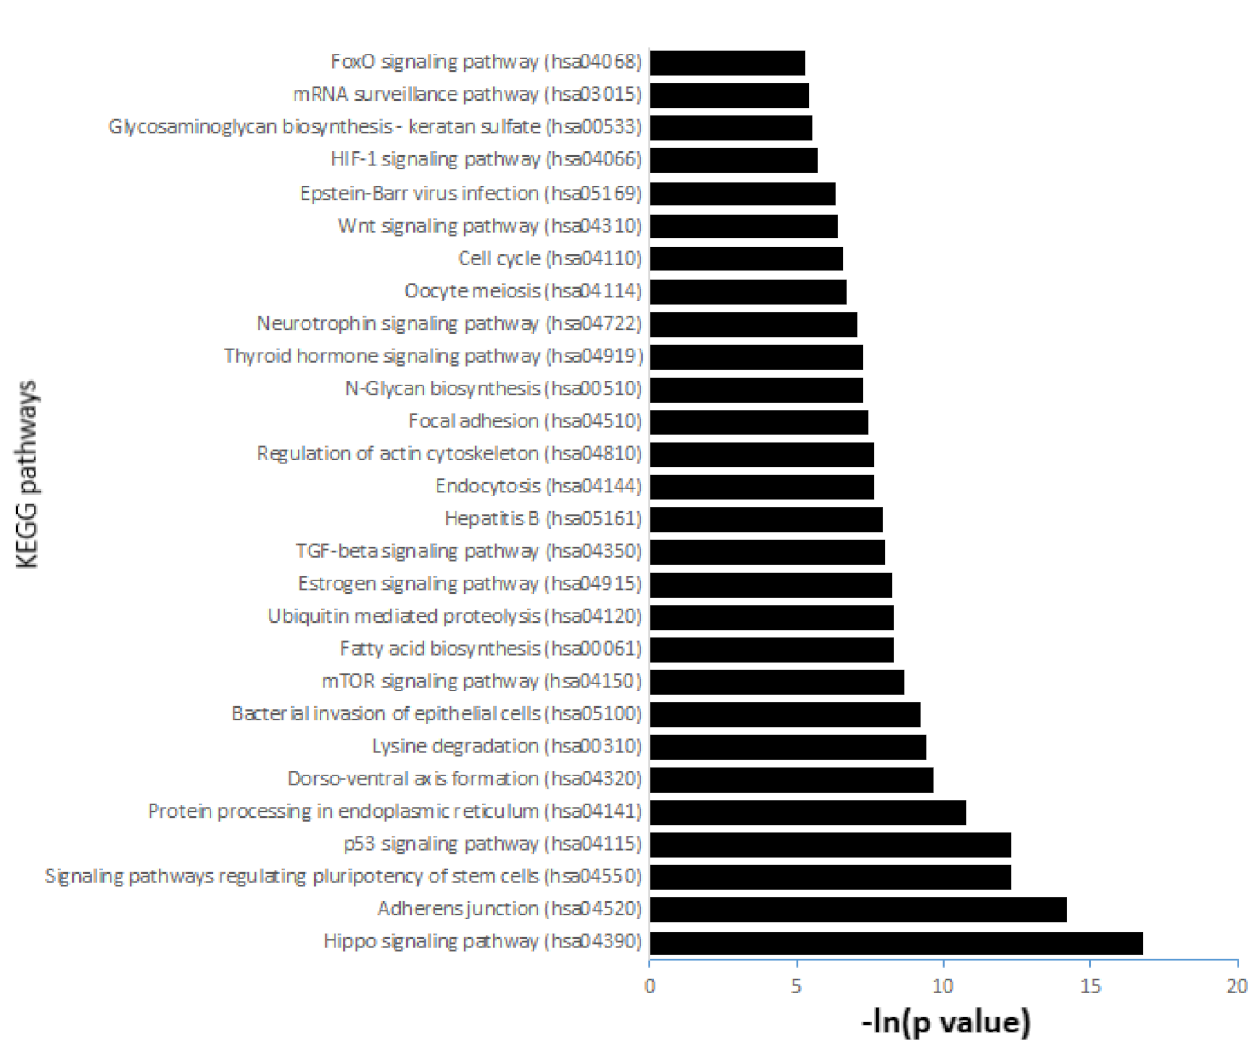
Figure 12. The KEGG pathway enrichment analysis of 11 microRNAs dysregulated in early preg- nancies destinated to develop GDM. The analysis revealed a total of 62 various pathways, where a majority of pathways have been shown to play a role in physiological processes and besides to the pathogenesis of cancer. The results were expressed as –ln of the p -value ( − ln( p -value)). The microRNA/KEGG pathway heatmap and hierarchical clustering demonstrated the level of involvement of particular microRNAs in various biological pathways (Figure